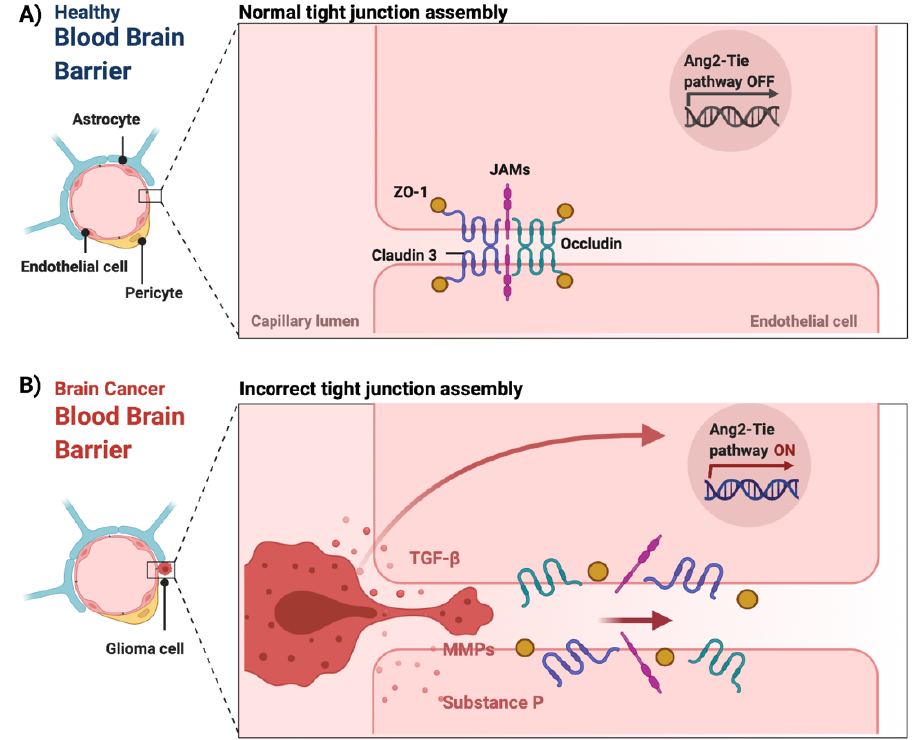
Figure 2. The integrity of the blood – brain barrier in physiological and malignant conditions. (A) In physiological conditions, tight junctions (claudin 3, occludin, junction adhesion molecules (JAMS) as well as cytoplasmic accessory proteins, such as Zonula occludens-1 (ZO-1)) of the endothelial cells remain intact maintaining the integrity of the BBB. (B) In CNS tumors, the release of chemical mediators by the tumor cells, such as substance P, matrix metalloproteinases (MMPs) and trans- forming growth factor beta (TGF- β) , can cause the loss of tight junctions, which leads to the dysfunction and disruption of the BBB [60,69,70,72]. Additionally, the overexpression of angiopoietin-2 (ANG-2) is linked to vascular malformations and pericyte detachment through the hypoxic up- regulation of VEGF, which subsequently promotes angiogenesis at the tumor margin [68]. Figure was created in BioRender.com (accessed on 20 May 2022).